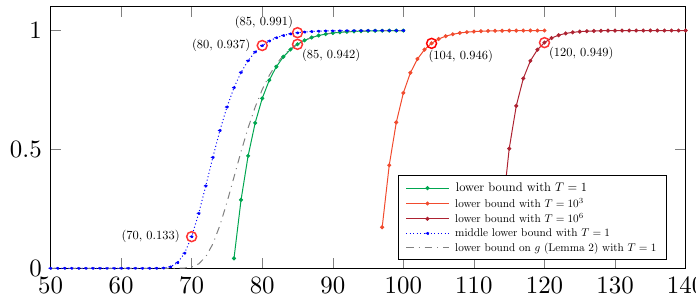
Figure 7: Success probability lower bound (Equation 10) over an increasing N for n = 16, m = 8, and |K| = 2 n